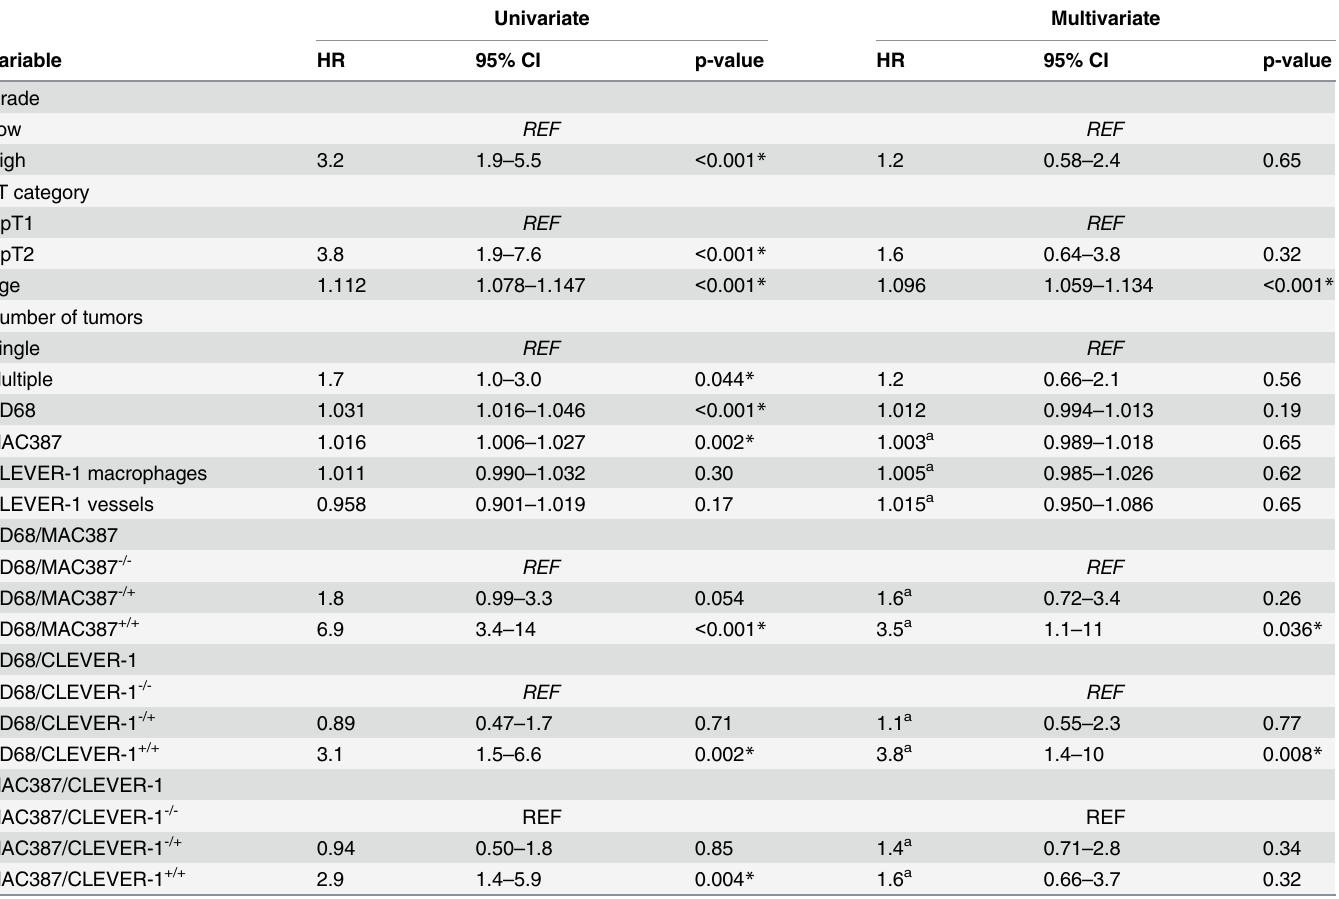
Table 3. Univariate and multivariate Cox proportional hazards regression analysis of factors affecting OS in the TUR-BT